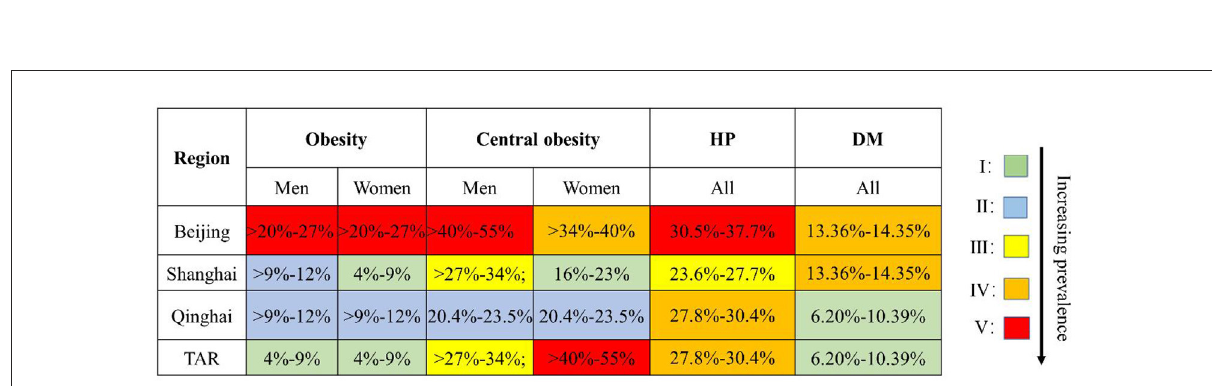
FIGURE5 Comparison of prevalence of obesity, central obesity, hypertension, and diabetes in Beijing, Shanghai, Qinghai, and TAR, 2013–2017. Obesity: I: 4–9%; II: > 9–12%; III: > 12–14%; IV: > 14–20%; V: > 20–27%. Central obesity: I: 16–23%; II: > 23–27%; III: > 27–34%; IV: > 34–40%; V: > 40–55%. Hypertension: I: 18.0–20.3%; II: 20.4–23.5%; III: 23.6–27.7%; IV: 27.8–30.4%; V: 30.5–37.7%. Diabetes: I: 6.20–10.39%; II: 10.64–11.93%; III: 11.99–12.90%; IV: 13.36–14.35%; V: 14.38–19.85%. TAR, Tibet Autonomous Region; HP, hypertension; DM, diabetes. The prevalence of obesity, central obesity, and hypertension was from China Chronic Disease and Risk Factor Surveillance Report (2013). The prevalence of diabetes was from a nationally representative study conducted in 2015–2017.